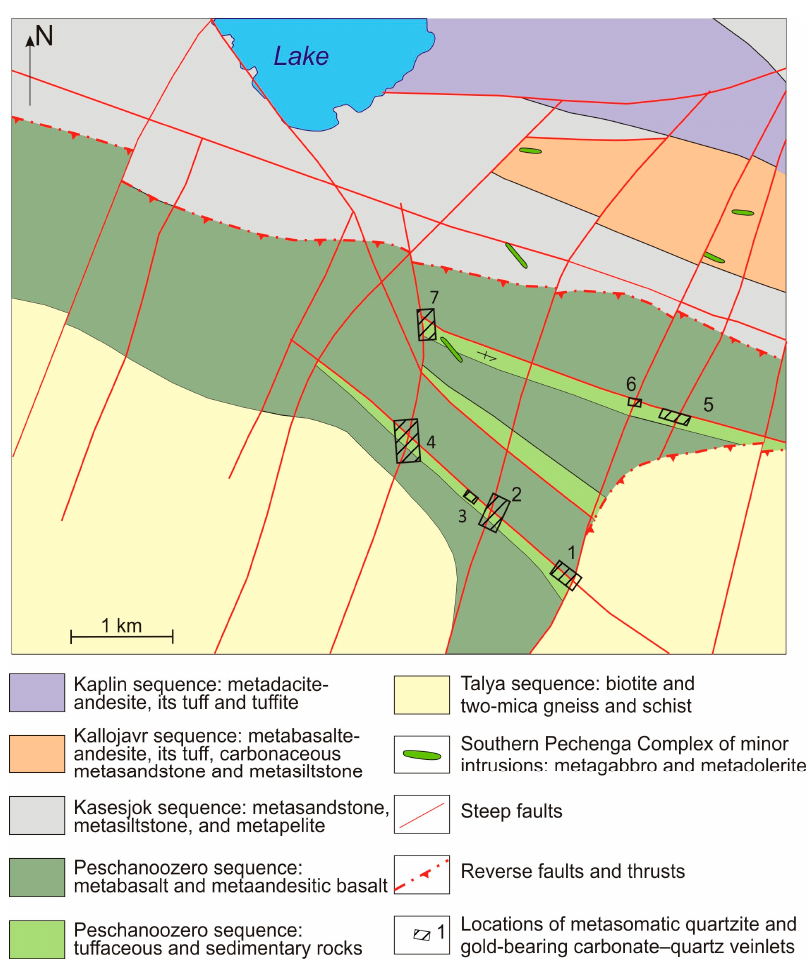
Figure 15. Schematic geological map of the Porojarvi area in the South Pechenga structure. Numerals are locations: (1) Timofeevsky, (2) Anomal’ny, (3) Zagadka, (4) Kontaktovy, (5) Svetlanovsky, (6) Istok, and (7) Porojarvinskoe.